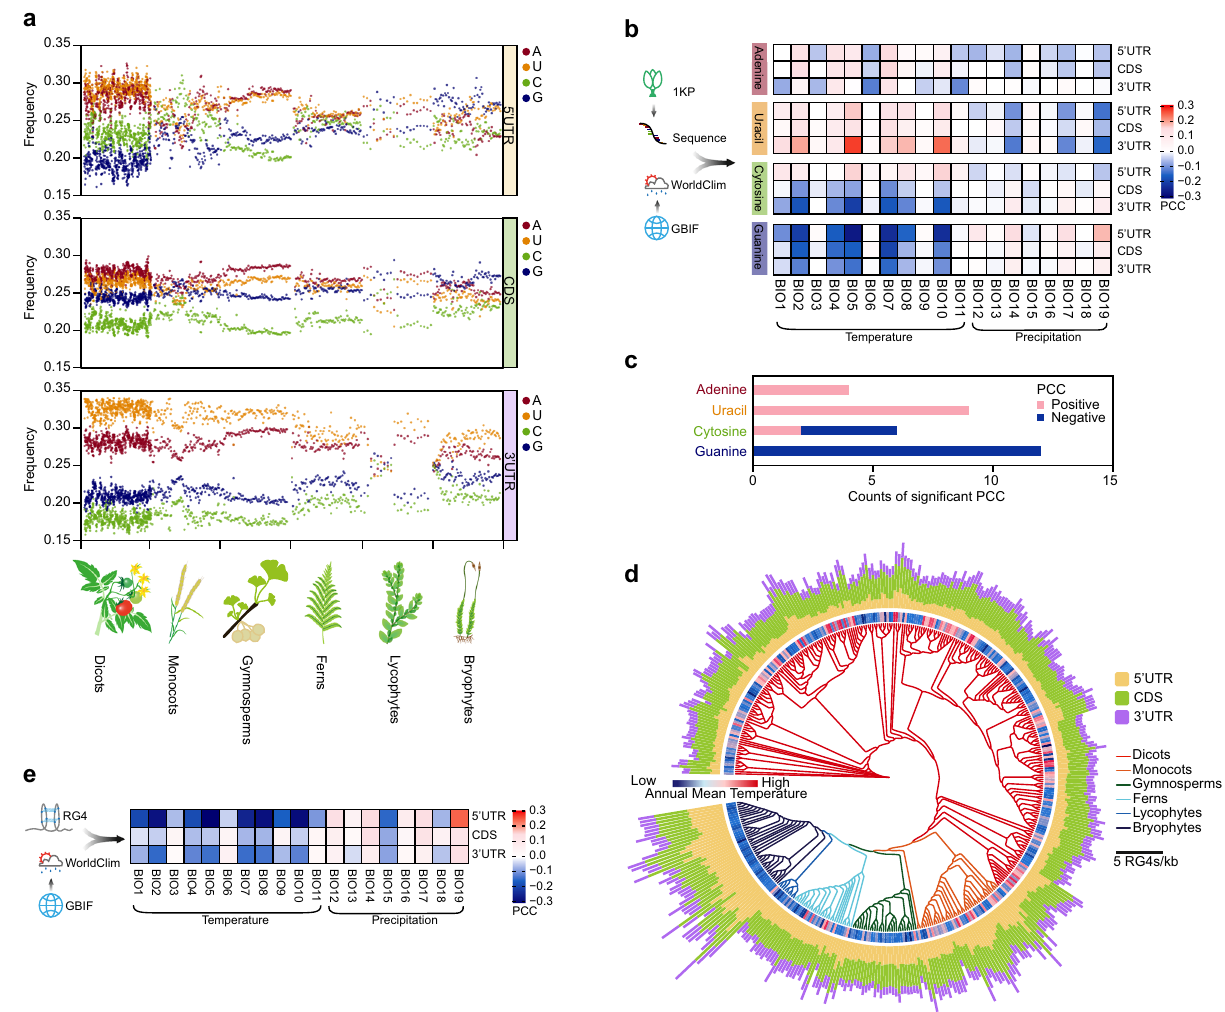
Fig. 1 | Comparison of transcriptomic guanine (G) frequencies and RNA G-quadruplex frequencies exhibit climatic signatures of plant adaptation. a Scatter plot showing the frequency of each nucleotide (A: adenine, U: uracil, C: cytosine,andG:guanine)intranscriptomesof906landplantsfromthe1000Plants (1KP Initiative) 6 . n =556, 107, 80, 71, 21, 71 for dicots, monocots, gymnosperms, ferns, lycophytes and bryophytes, respectively. b Heat plot showing the Pearson Correlation Coef fi cient (PCC) between transcriptomic nucleotide frequency and bioclimaticvariablesofplanthabitats.Thefrequenciesofthefournucleotideswere calculated in 906 land plants derived from the transcriptomes of the 1000 Plants (1KP).The corresponding plant habitats were sourced fromtheGlobalBiodiversity Information Facility (GBIF). The bioclimatic variables of these plant habitats were derived fromthe WorldClimdatabase, i.e., BIO1:annualmeantemperature(forfull details see Materials and Methods), as explained by WorldClim (https://www.